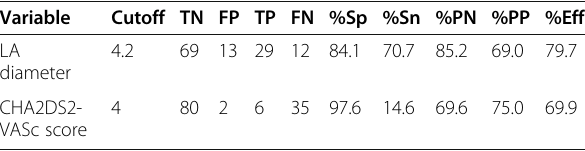
Table 4 The diagnostic performance of postoperative atrial fibrillation predictors Variable